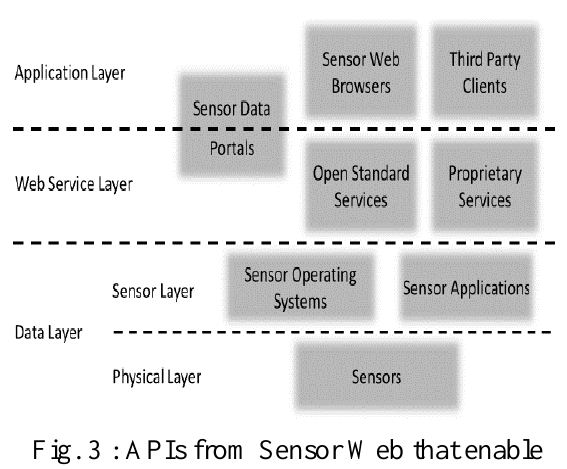
Fig. 3 : APIs from Sensor Web that enable integration with outside frameworks.